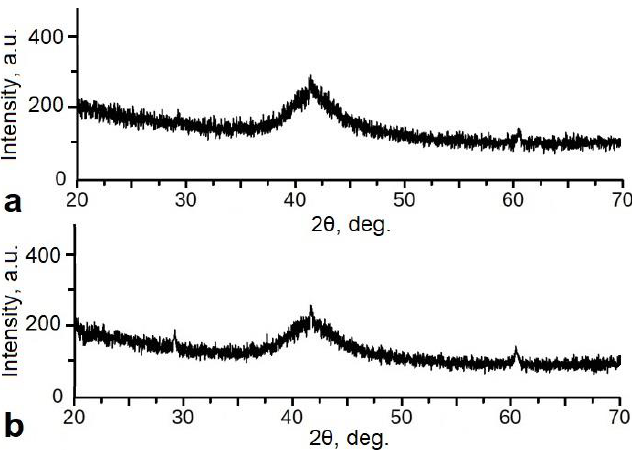
Figure 3. Typical XRD patterns of the as-quenched TiNiCu alloy ribbons with 30 at.% Cu from the contact ( a ) and non-contact ( b ) sides.